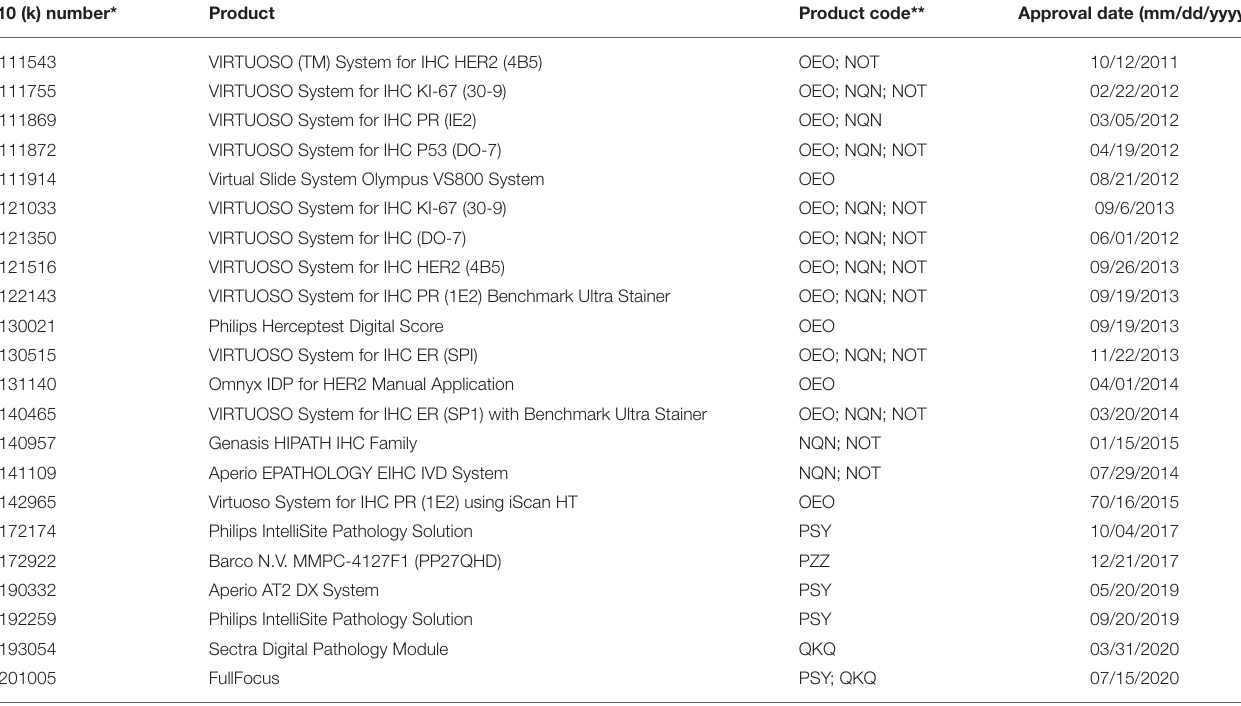
TABLE 5 | FDA cleared digital pathology devices within the last 10